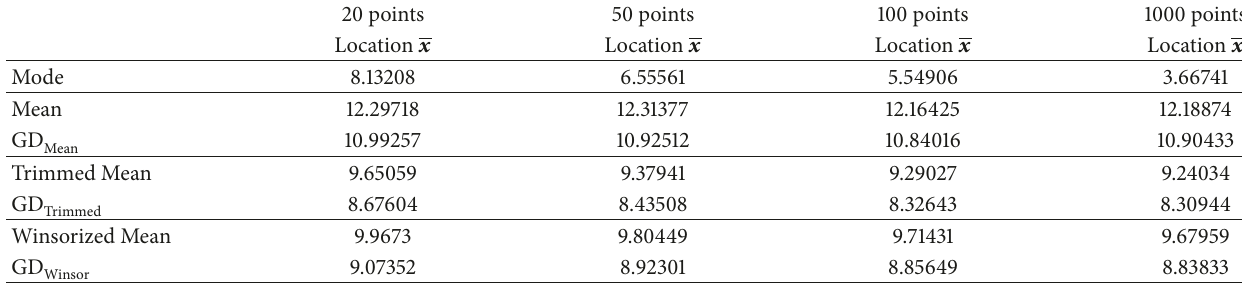
Table 18: Log-normal distributions with 50% noise level.